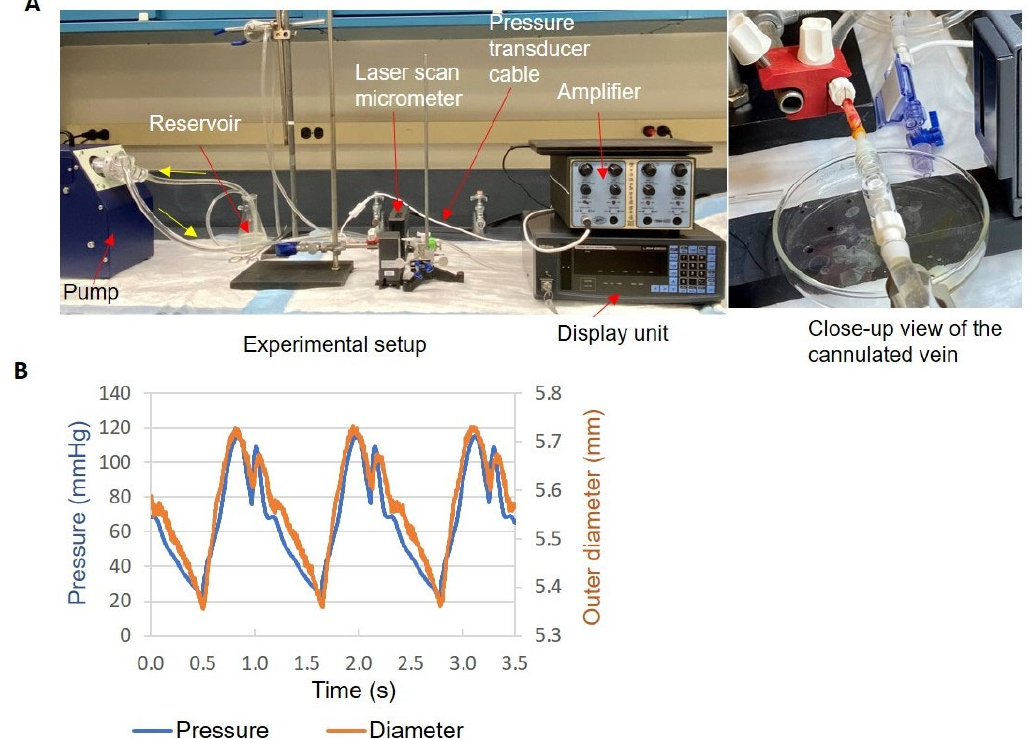
Figure 7. Human Vein Distensibility Assessment Using a Perfusion System. Distensibility of the veins were tested after VRS-AVF treatment with or without the step of light activation using the bench top perfusion system shown in Panel ( A ). Panel ( B ) illustrates an example of the measured pulsatile pressure and outer diameter tracings in three perfusion cycles. The blue line on the graph represents cyclical changes in the intraluminal pressure, and the red line represents the correspond- ing changes in the outer diameter of the veins detected by a laser scan micrometer. Table 1. Human Vein Bench Top Biomechanics Test Conditions and Results.